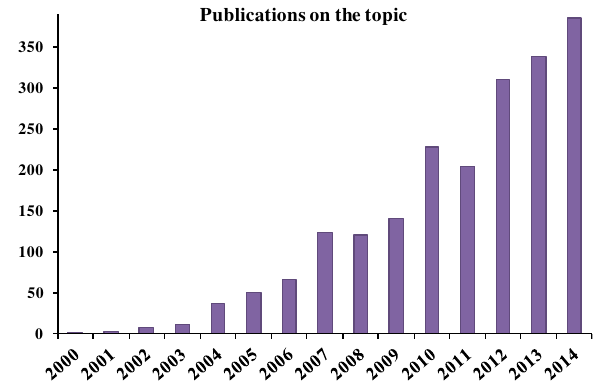
Figure 2. The number of publications on organocatalysis, obtained by searching ‘ organocatalysis ’ in Sci fi nder. For the year 2014, the number has been calculated until December 15th, 2014. See Ref. [23].